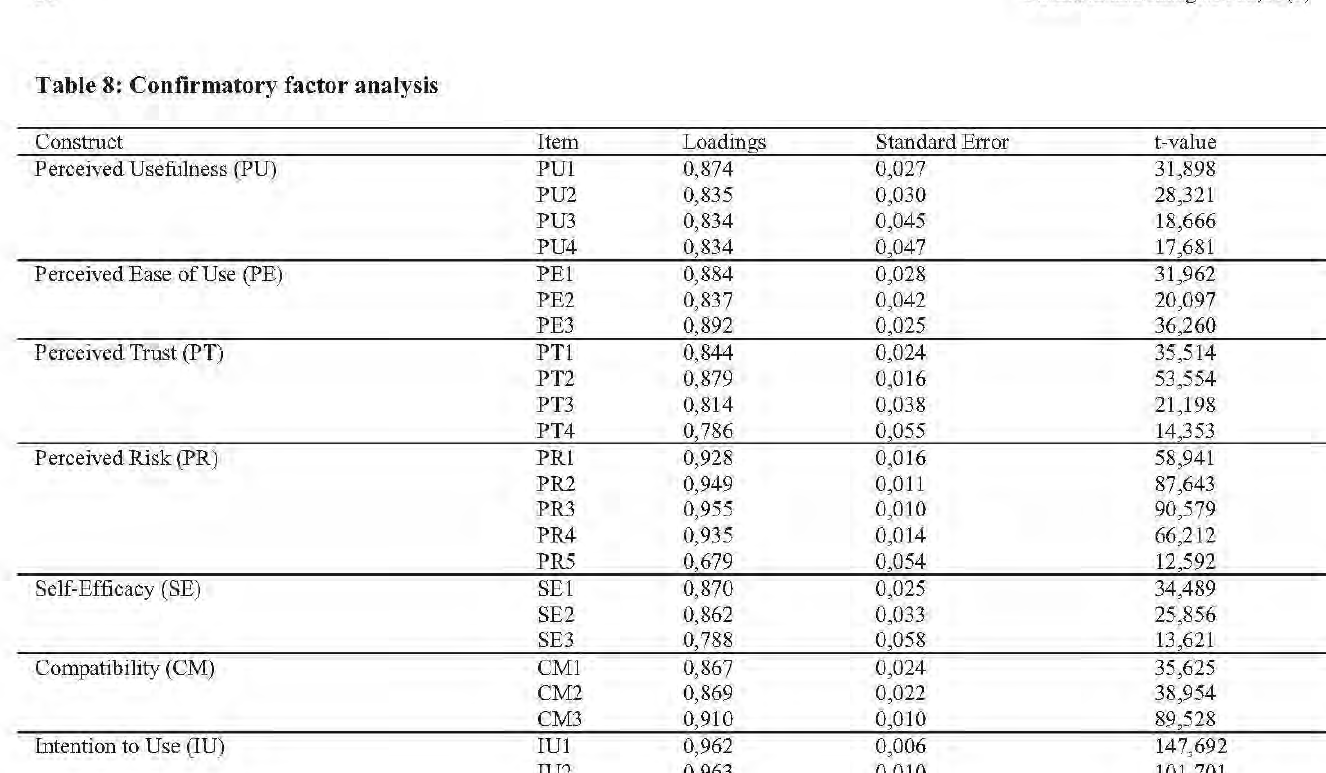
Table 8: Confirmatory factor analysis